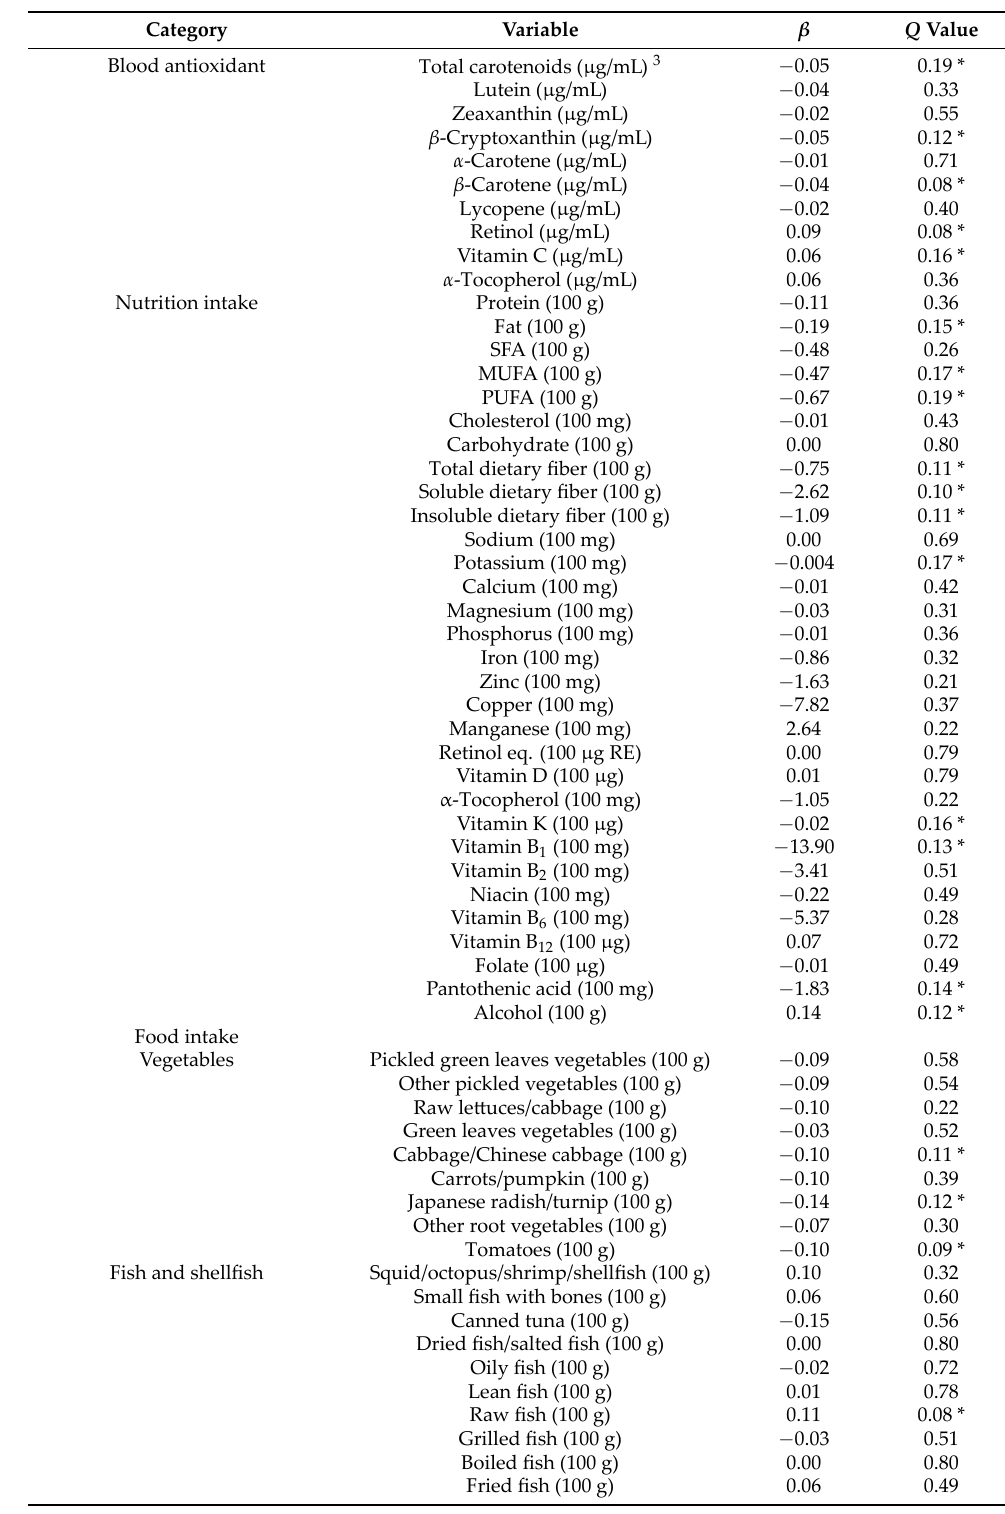
Table 4. Association between plasma LBP concentration and dietary factors 1,2 (Only categories that were significantly associated with plasma LBP concentrations are